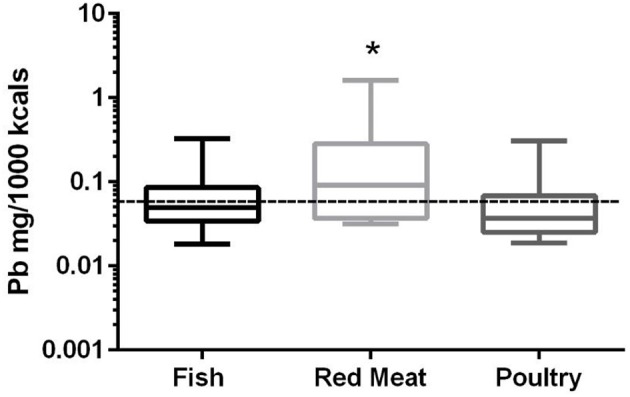
Box-and-whisker plots of the log lead concentrations in fish, poultry and red meat-based dry dog foods (17 dog foods representing each for animal based protein source). Boxes represent the 25 and 75th percentiles, and whiskers represent the minimum and maximum. Solid lines within boxes represent the median values. Dashed lines indicate human intake (mg/Mcal) based on mean daily consumption. *indicates a significant difference from poultry but not fish based diets (p < 0.03).